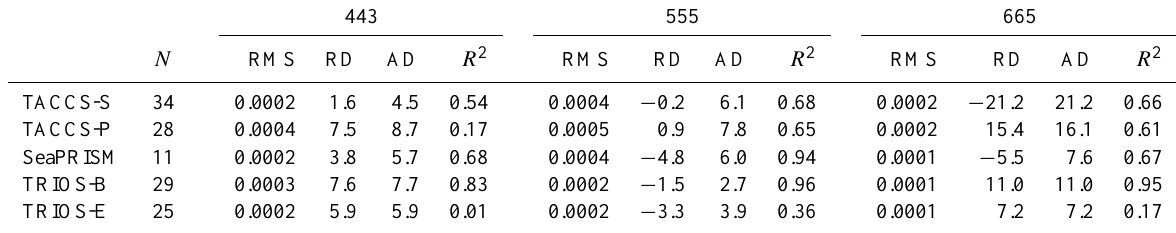
Table 12. As in Table 10 but for R rs (λ) .